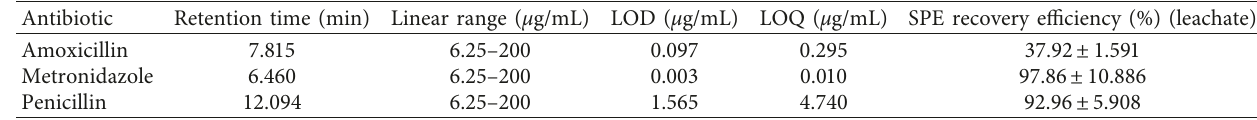
Table 2: A summary of retention time, method LOD, LOQ, LR, and SPE recoveries of antibiotics from leachate and soil samples.